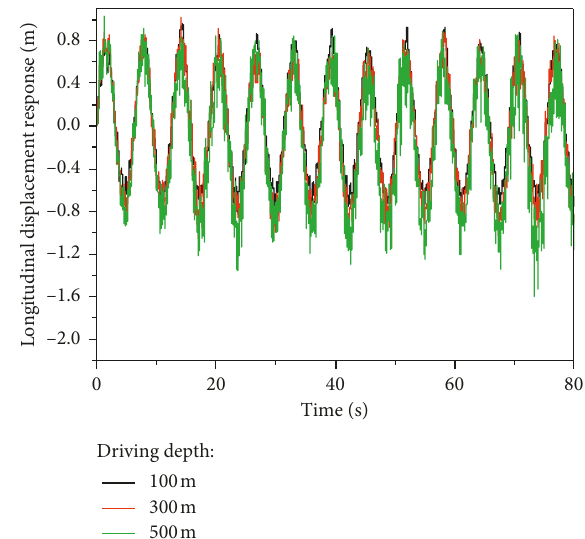
Figure 25: Effect of driving depth on longitudinal displacement response.